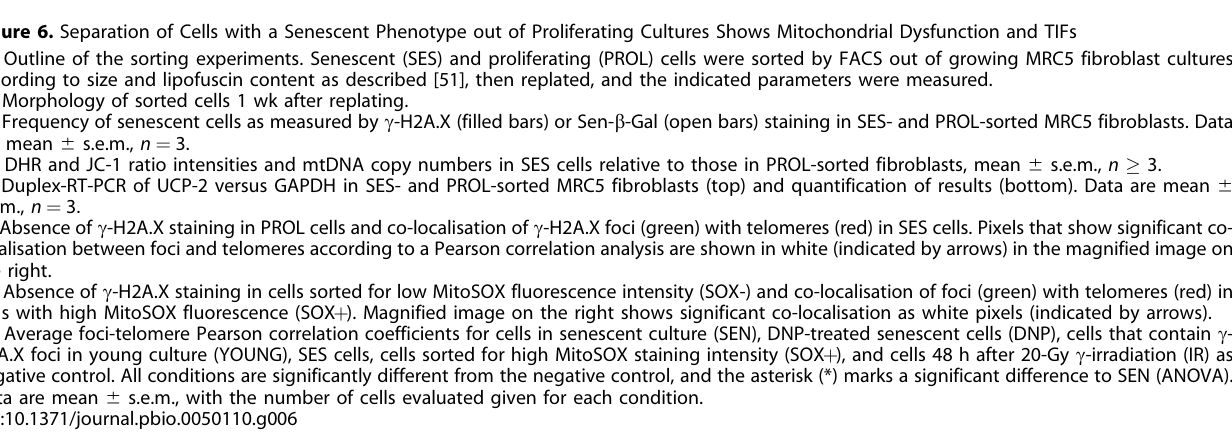
Figure 6. Separation of Cells with a Senescent Phenotype out of Proliferating Cultures Shows Mitochondrial Dysfunction and TIFs (A) Outline of the sorting experiments. Senescent (SES) and proliferating (PROL) cells were sorted by FACS out of growing MRC5 fibroblast cultures according to size and lipofuscin content as described [51], then replated, and the indicated parameters were measured. (B) Morphology of sorted cells 1 wk after replating. (C) Frequency of senescent cells as measured by c -H2A.X (filled bars) or Sen- b -Gal (open bars) staining in SES- and PROL-sorted MRC5 fibroblasts. Data are mean 6 s.e.m., n ¼ 3. (D) DHR and JC-1 ratio intensities and mtDNA copy numbers in SES cells relative to those in PROL-sorted fibroblasts, mean 6 s.e.m., n (cid:3) 3. (E) Duplex-RT-PCR of UCP-2 versus GAPDH in SES- and PROL-sorted MRC5 fibroblasts (top) and quantification of results (bottom). Data are mean 6 s.e.m., n ¼ 3. (F) Absence of c -H2A.X staining in PROL cells and co-localisation of c -H2A.X foci (green) with telomeres (red) in SES cells. Pixels that show significant co- localisation between foci and telomeres according to a Pearson correlation analysis are shown in white (indicated by arrows) in the magnified image on the right. (G) Absence of c -H2A.X staining in cells sorted for low MitoSOX fluorescence intensity (SOX-) and co-localisation of foci (green) with telomeres (red) in cells with high MitoSOX fluorescence (SOX þ ). Magnified image on the right shows significant co-localisation as white pixels (indicated by arrows). (H) Average foci-telomere Pearson correlation coefficients for cells in senescent culture (SEN), DNP-treated senescent cells (DNP), cells that contain c - H2A.X foci in young culture (YOUNG), SES cells, cells sorted for high MitoSOX staining intensity (SOX þ ), and cells 48 h after 20-Gy c -irradiation (IR) as negative control. All conditions are significantly different from the negative control, and the asterisk (*) marks a significant difference to SEN (ANOVA). Data are mean 6 s.e.m., with the number of cells evaluated given for each condition.